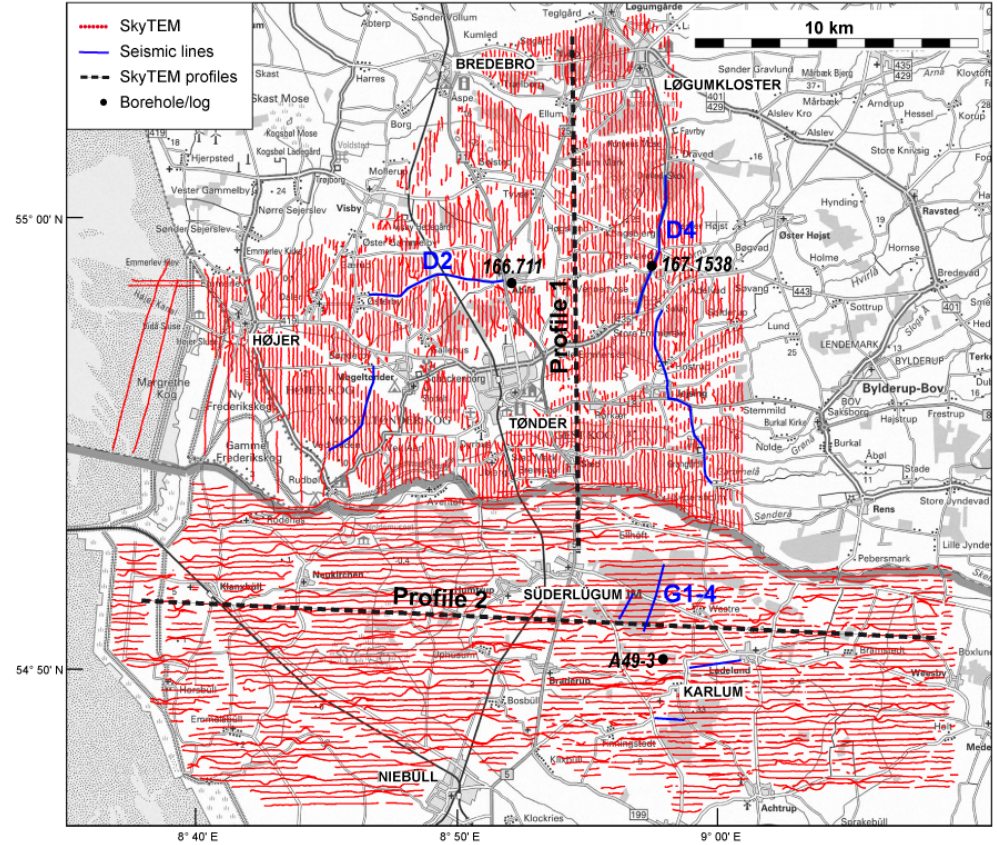
Fig. 5. Map with SkyTEM data after processing (red lines) and seismic data (blue lines). The flight lines of the Tønder survey are north– south oriented. The flight lines of the Leck survey are west–east oriented. Seismic sections D2, D4 and G1–4 are shown in Figs. 6, 7 and 8. Unlabelled profiles were collected, but are not shown. SkyTEM profiles 1 and 2 indicated on the map are shown in Fig. 11. The locations of boreholes 167.711, 167.1538 and A49-3 are also